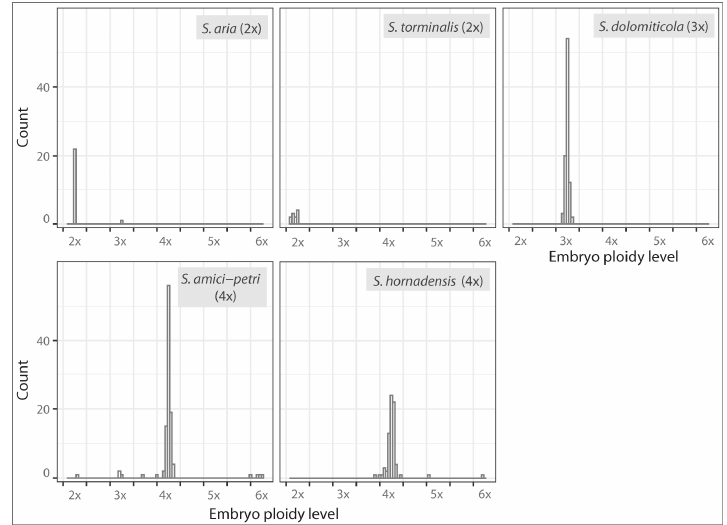
Figure 5. Calculated embryo ploidy levels of 305 seeds of Sorbus analyzed in the present study. The estimated euploid and aneuploid ploidy level categories are separated by vertical lines.